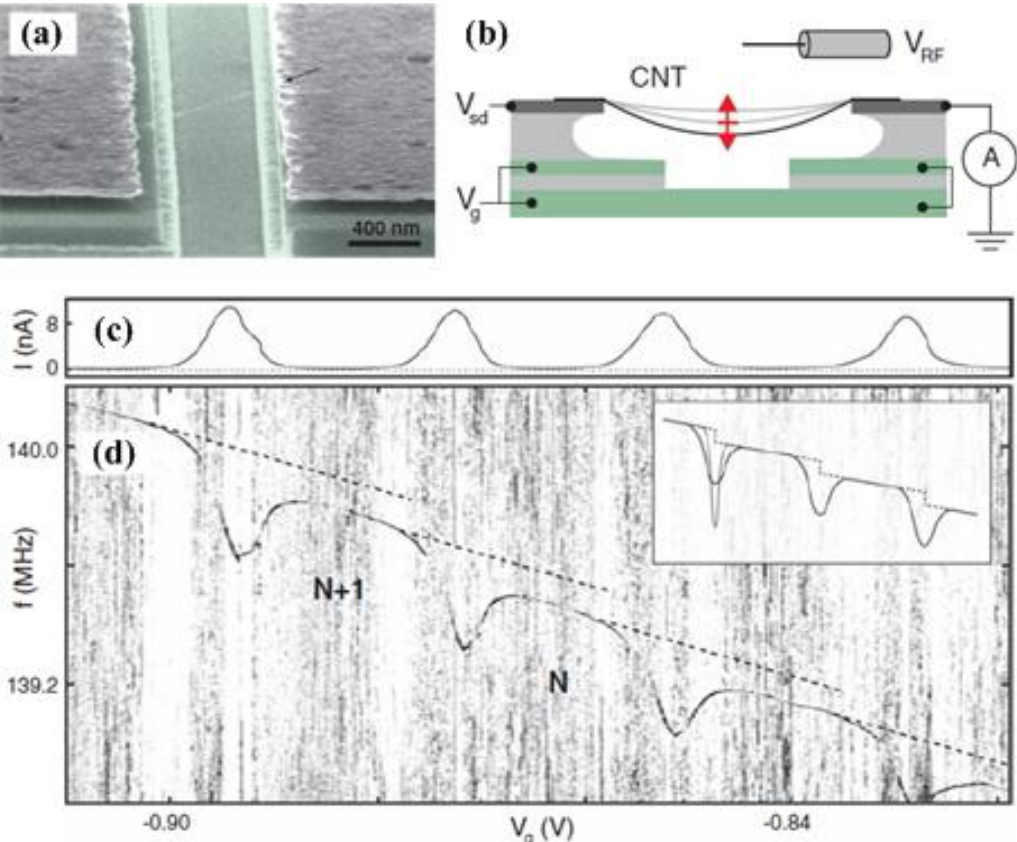
Figure 22. Single-electron tuning mechanism developed by Steele et al . [293]. ( a ) Nanotube mechanical resonator; ( b ) Device geometry for single-electron tuning; ( c ) Single-electron Coulomb blockade oscillations; ( d ) Tuning the resonant frequency with gate voltage. Reused with permission from [293], Copyright 2009 American Association for the Advancement of